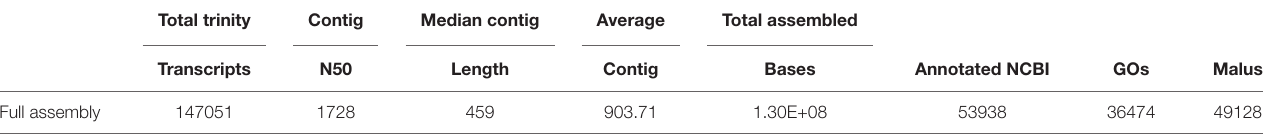
TABLE 1 | Statistical summary of parthenocarpic and pollinated ripening fig fruit transcriptome